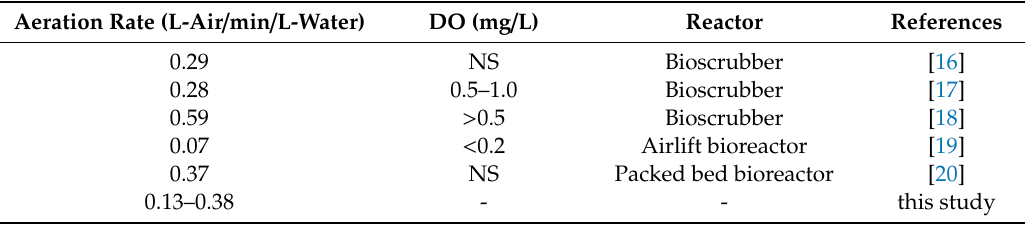
Figure 4. Changes in normalized H 2 S concentration with and without SOB media at di ff erent aeration rates. Table 2. Aeration rate and DO concentration in previous studies and in this